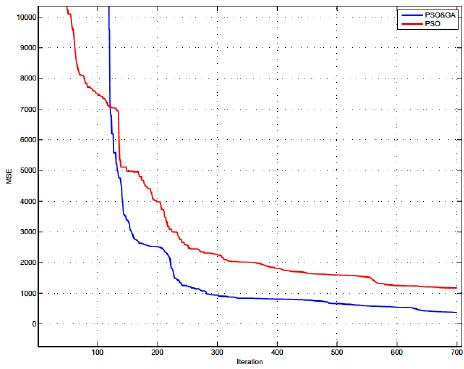
Figure 9. The value of MSE in all iterations with basic PSO and GA-PSO.